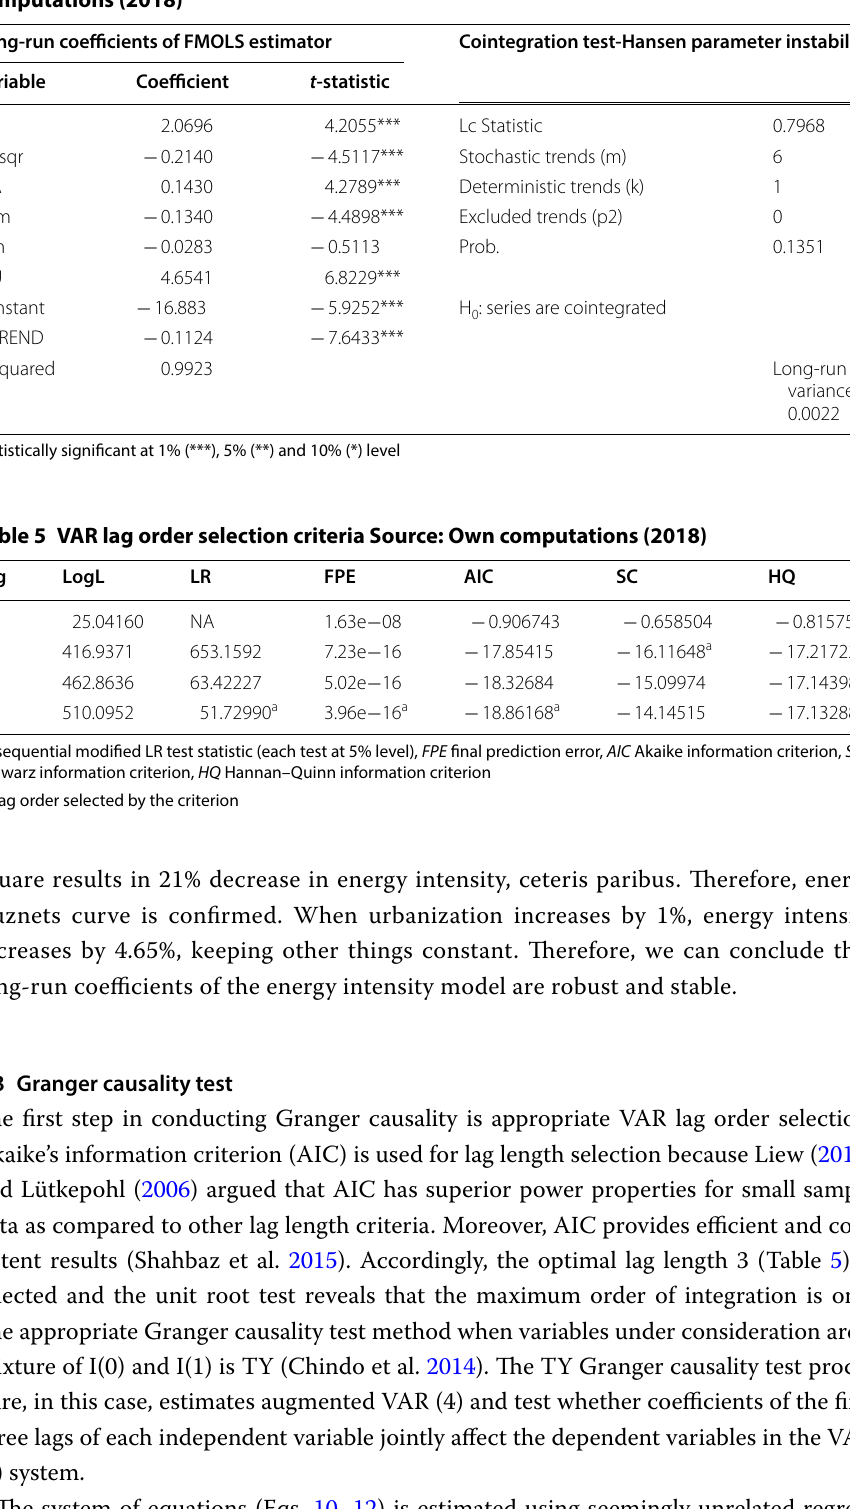
Table 4 Long-run coefficients of FMOLS estimator and cointegration test Source: Own computations (2018)